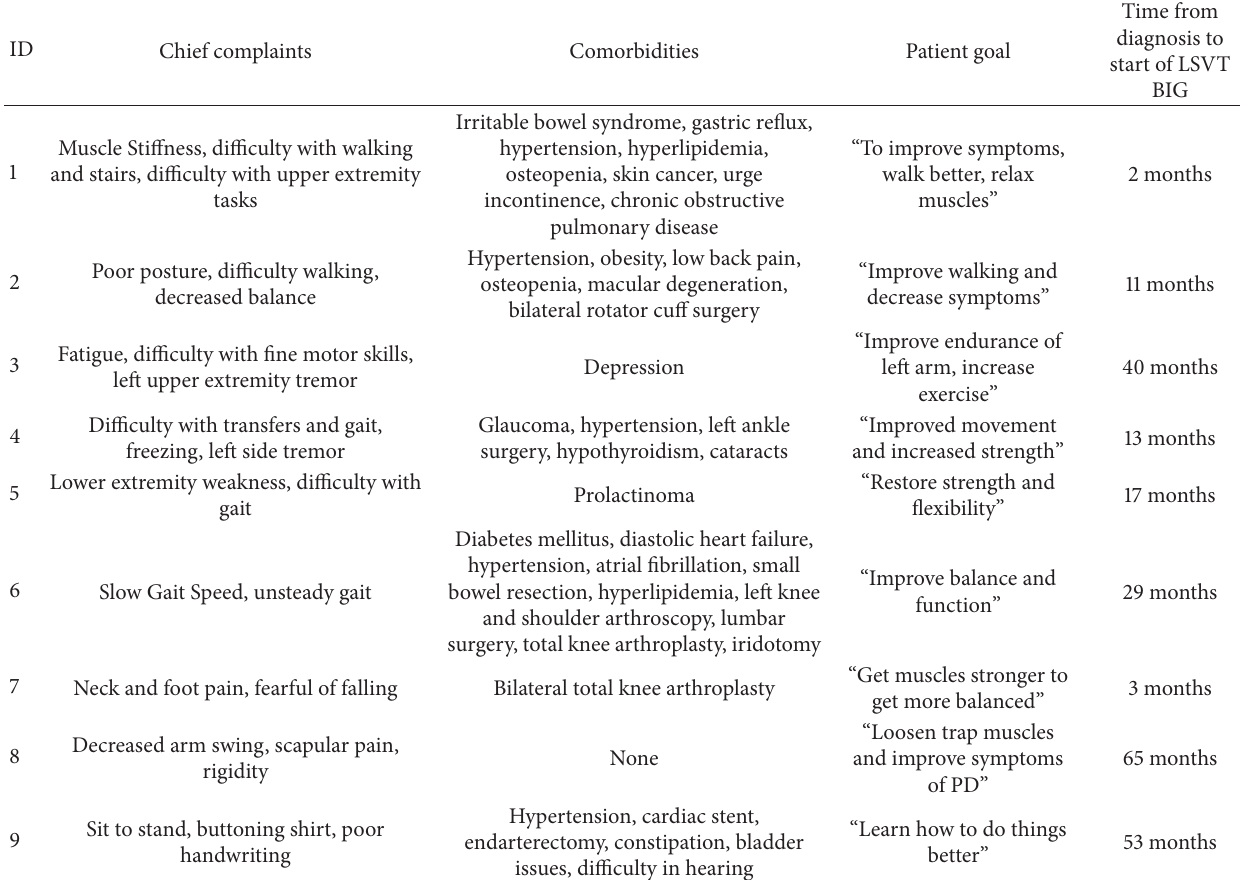
Table 2: Clinical characteristics of participants.